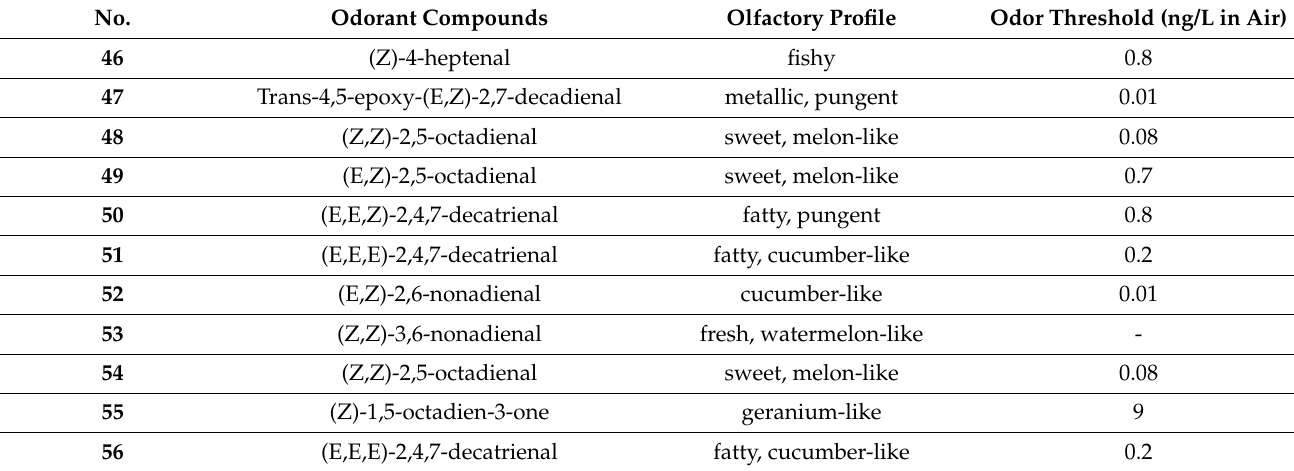
Table 3. Key aroma compounds with marine odor formed from autoxidized unsaturated fatty acids.